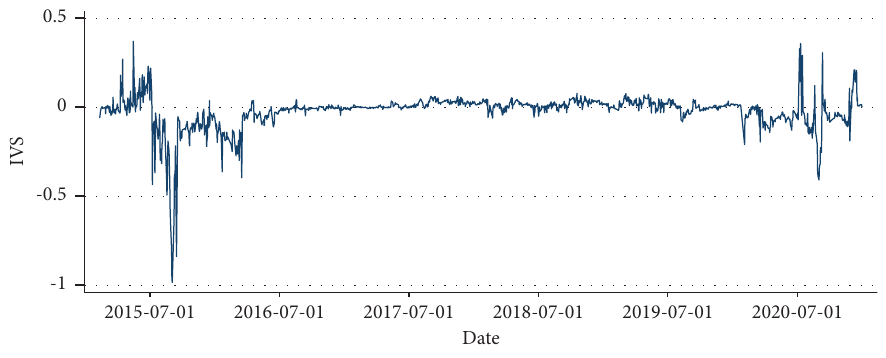
Figure 2: IVS original data chart of SSE 50ETF options.